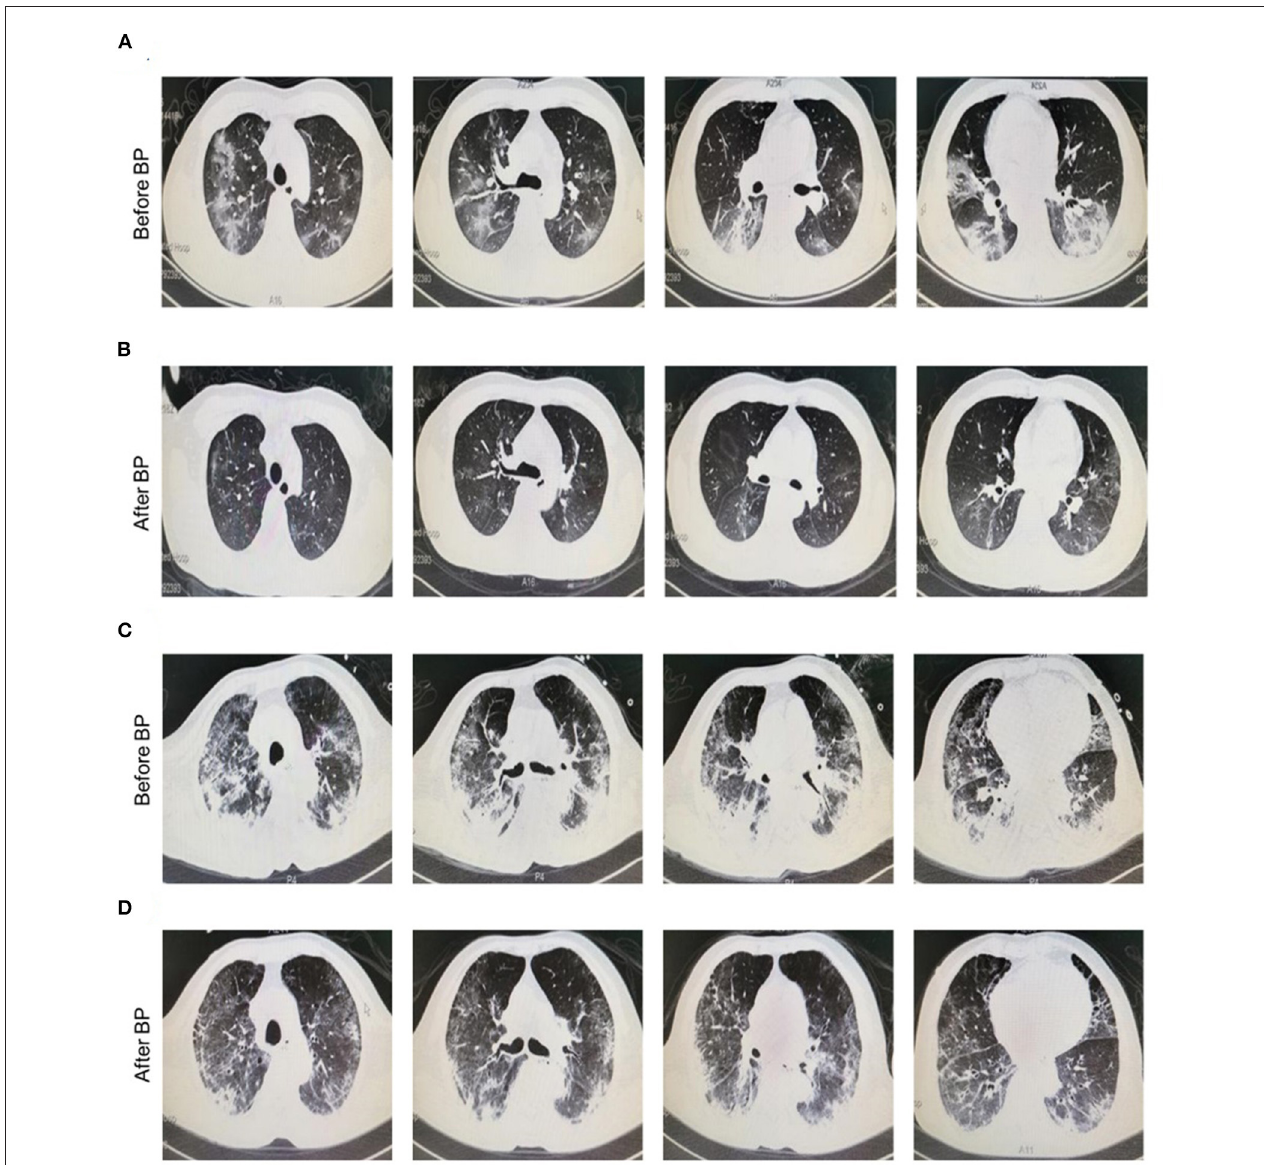
FIGURE 1 | Chest radiographs of COVID-19 patients before and after blood purification. (A,B) Representative chest CT manifestation of a 35 year old male patient with severe COVID-19 infection before (A) and after (B) blood purification treatment. This patient was diagnosed with dyspnea (FiO2, 41%, SpO2, 90%) and received HFNC and blood purification via CVVH/CVVHDF for one time. Finally, he was discharged from hospital with negative result of nuclei acid test (NAT). The typical ground-glass lesion as well as the inflammatory exudate in the lung of the case with severe COVID-19 infection before and after blood purification indicated the favorable prognosis. (C,D) Representative chest CT manifestation of a 75 year old male patient with critical COVID-19 infection before (C) and after (D) blood purification treatment. The lung of the patient with infiltrating ground-glass opacity in imaging before blood purification was significantly alleviated after treatment. The patient was diagnosed with ARDS, MODS, COPD and had comorbidities of type II diabetes and CHD. Before and after blood purification, the patient was positive and negative for NAT for SARS-CoV-2 in pharyngeal swabs, nasal swabs, stools and saliva, and turned negative after treatment, respectively.